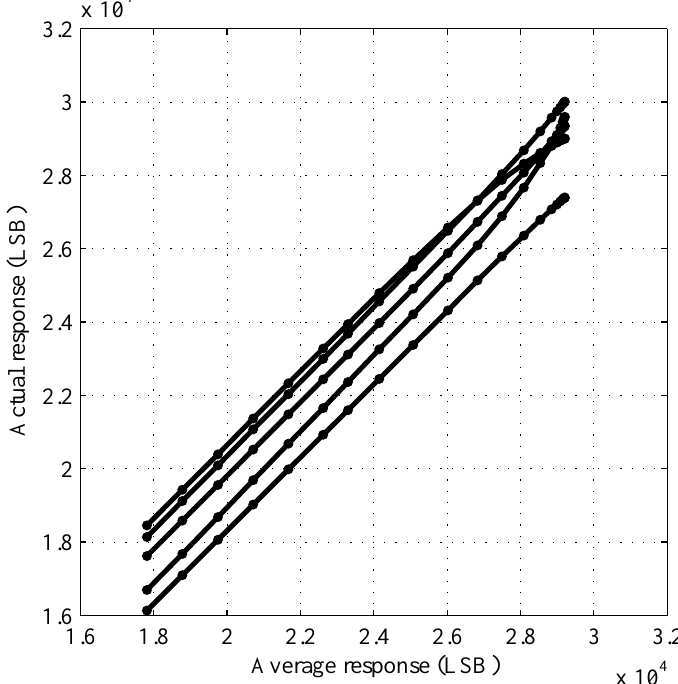
Figure 3. Actual response versus average response. Because of mismatch variation, which causes FPN, the actual response of any pixel—five are shown—varies relative to the average response of all pixels. The average response is considered to be an ideal